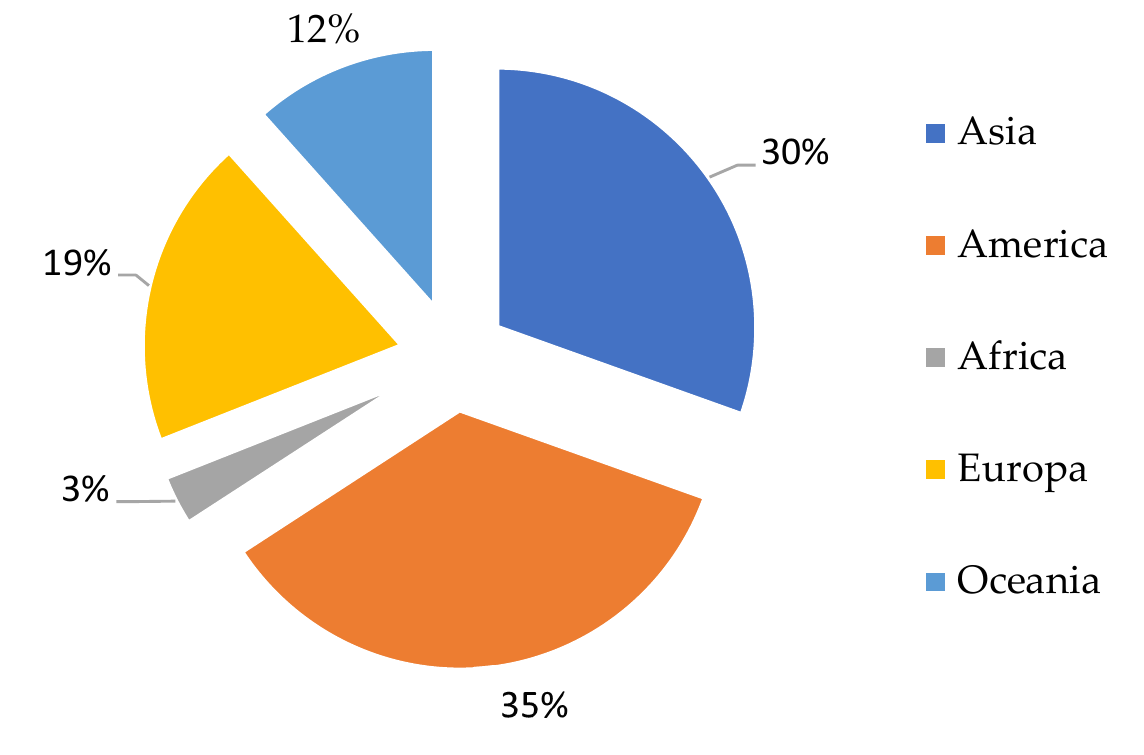
Figure 5. Cites by